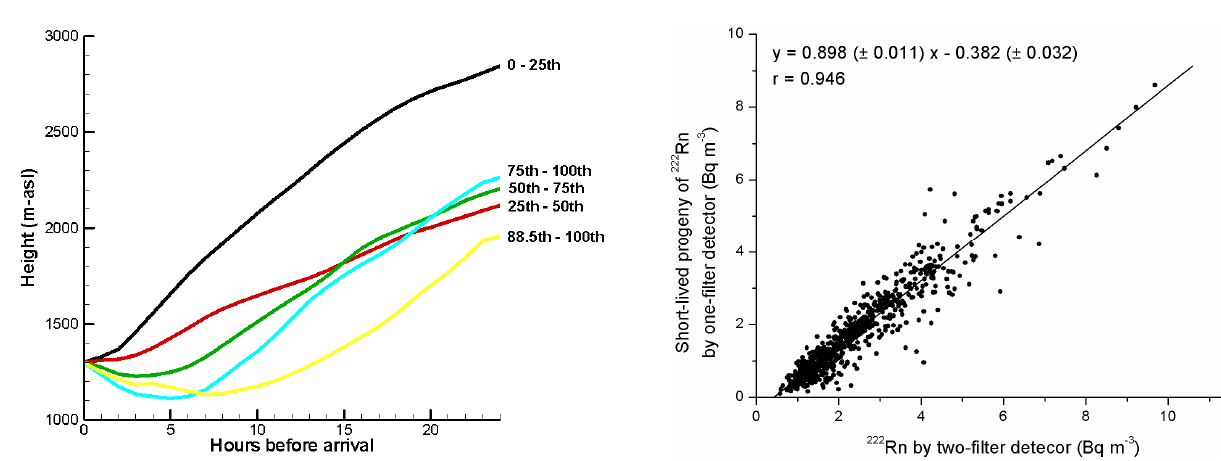
Fig. 5. Correlation between activity concentrations of 222 Rn (measured by two-filter detector) and short-lived 222 Rn progeny (expressed in 222 Rn equivalent; measured by one-filter detector) as determined by the two independently calibrated instruments for events with no surface wet deposition and wind from the reference sector (values in brackets are standard errors of regression parameters). The Spearman rank correlation coefficient r equals 0.946.